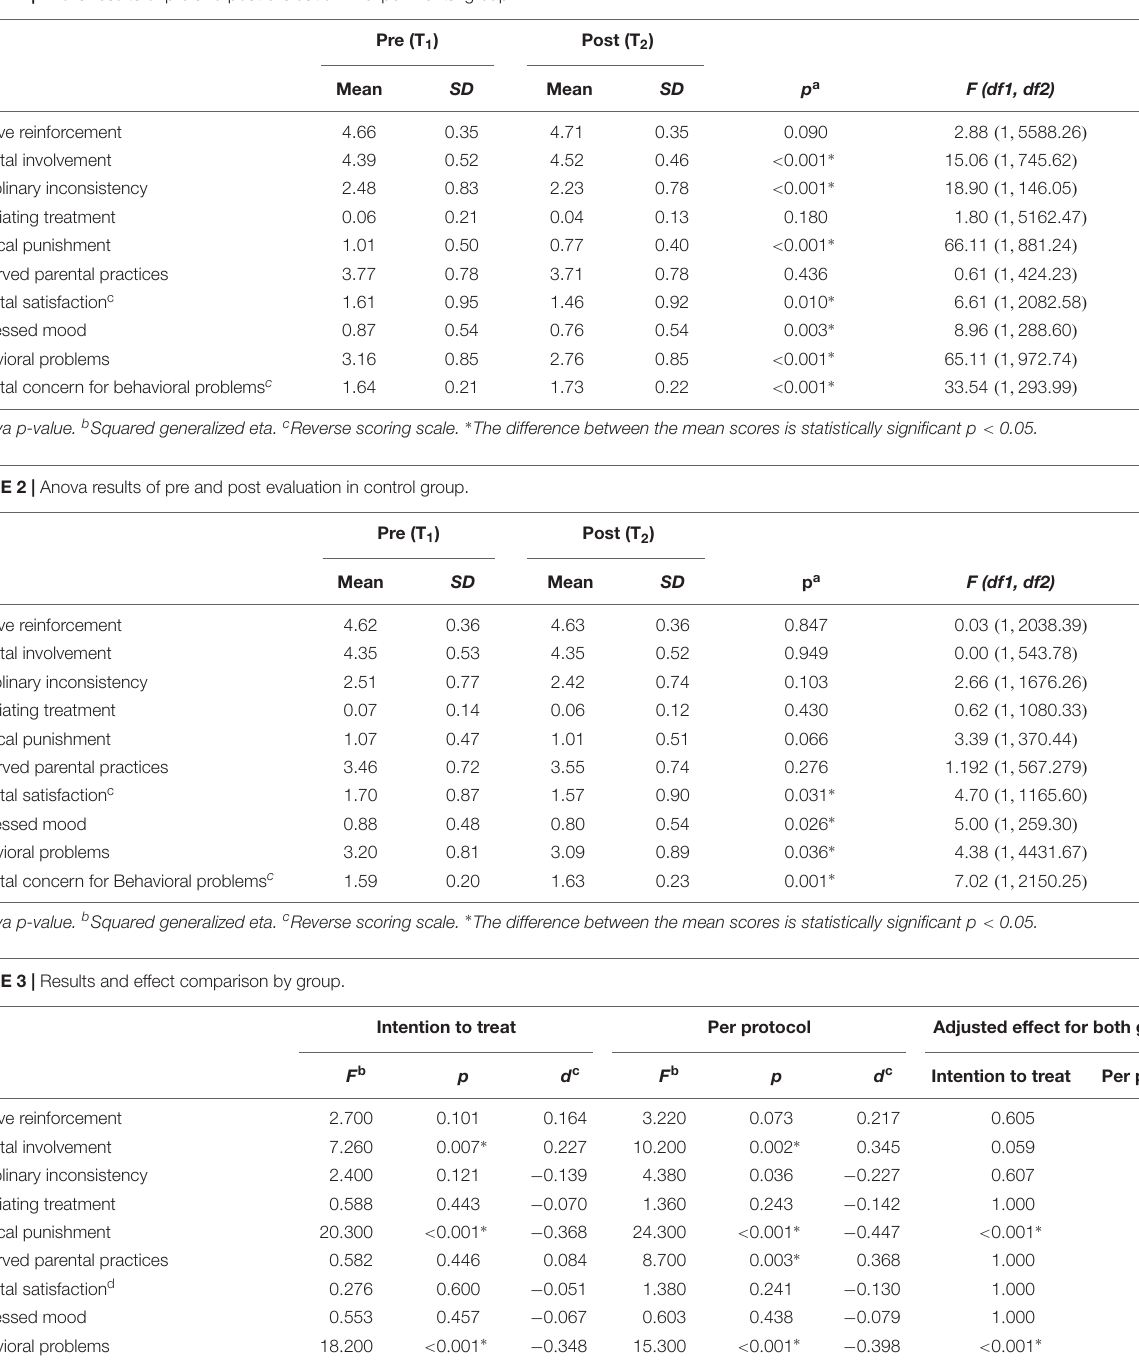
TABLE 1 | Anova results of pre and post evaluation in experimental group.